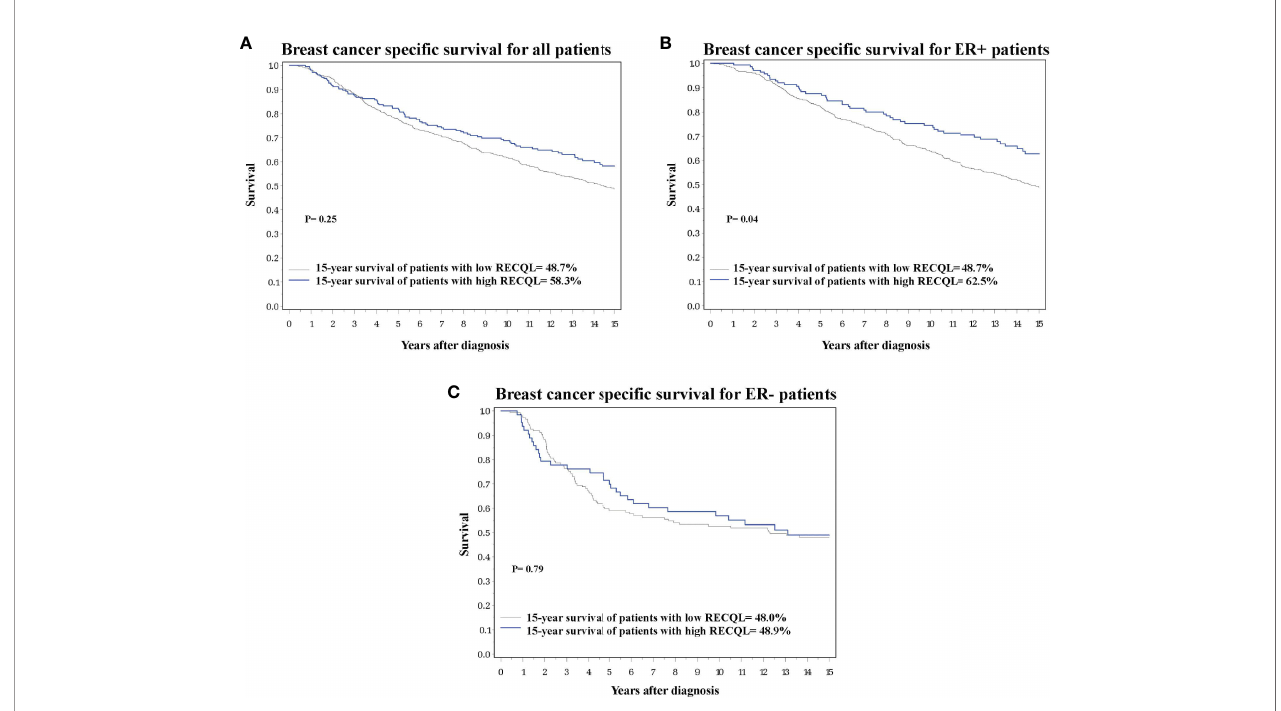
FIGURE 1 | Breast cancer speci fi c survival based on RECQL protein expression. (A) Breast cancer speci fi c survival in the entire dataset based on RECQL protein expression. (B) Breast cancer speci fi c survival in ER-positive patients based on RECQL protein expression. (C) Breast cancer speci fi c survival in ER- patients based on RECQL protein